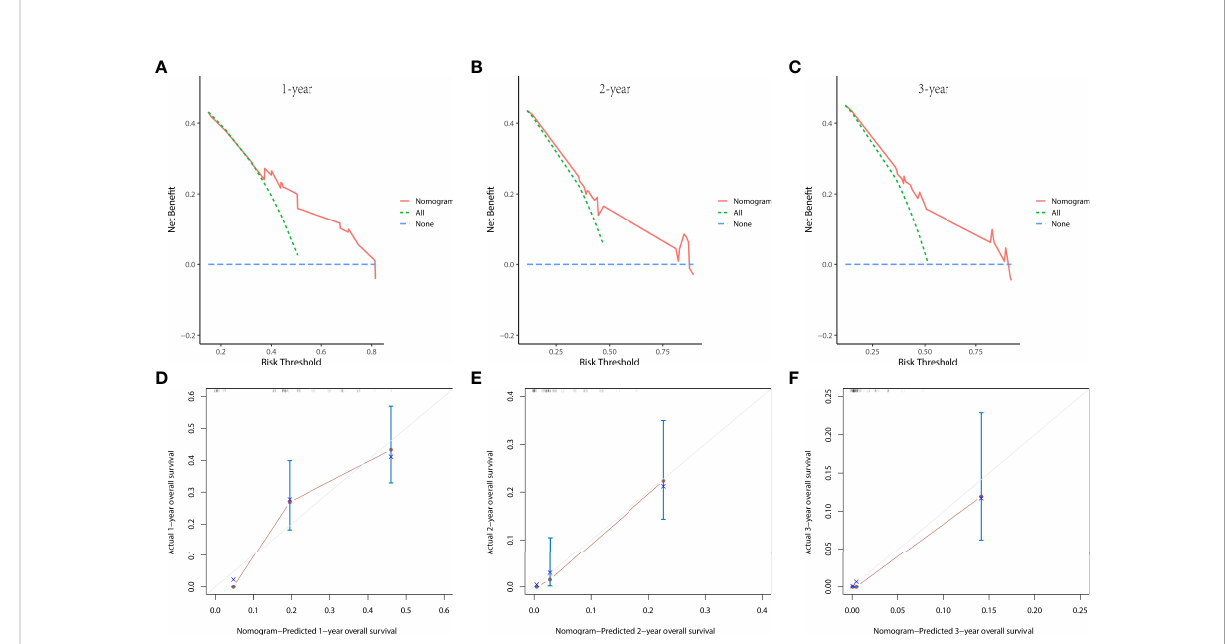
FIGURE 4 The decision curve analysis (DCA) curves at 1 (A) , 2 (B) , and 3 years (C) and the calibration curves at 1 (D) , 2 (E) , and 3 years (F) in the training group were used to evaluate the reliability of the prognostic